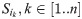
Monte-Carlo bootstrap procedure: Si is sampled n = 1000 times (with repetitions) to create the series Sik,k∈[1..n].Then, we measure the KS distance from Si to each of the sampled CDFs, yielding the group of distances {dik},k∈[1‥n].